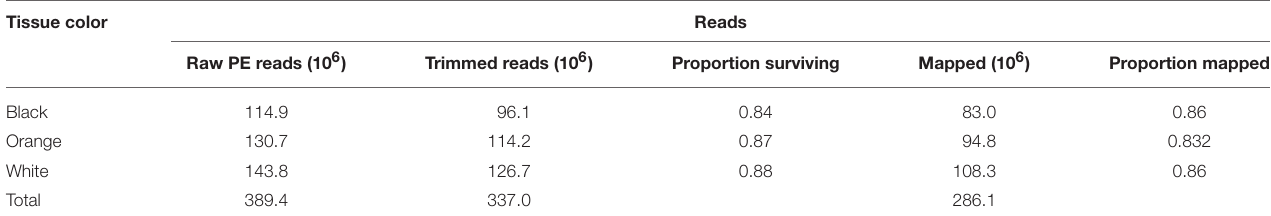
TABLE 1 | Summary of RNA libraries, including the tissue color, raw 100 bp paired-end reads (“PE Reads”), trimmed reads, proportion of reads surviving quality control, mapped reads and the proportion of reads that mapped to the Amphiprion percula transcriptome. Tissue